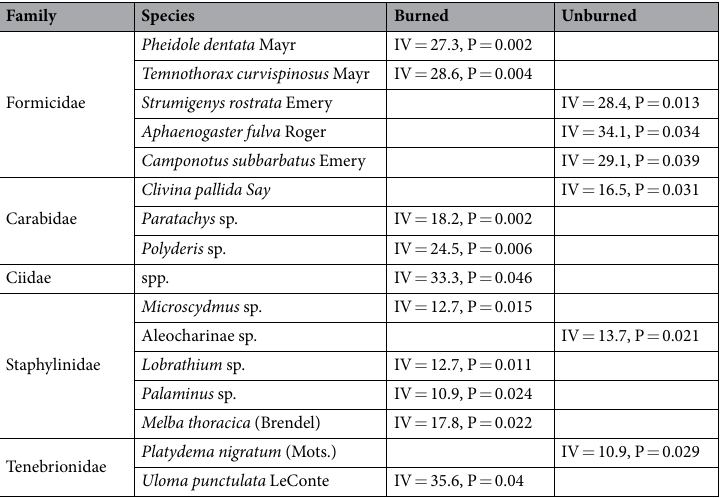
Table 3. Ants and beetles found to be significantly associated with burned or unburned logs based on indicator species